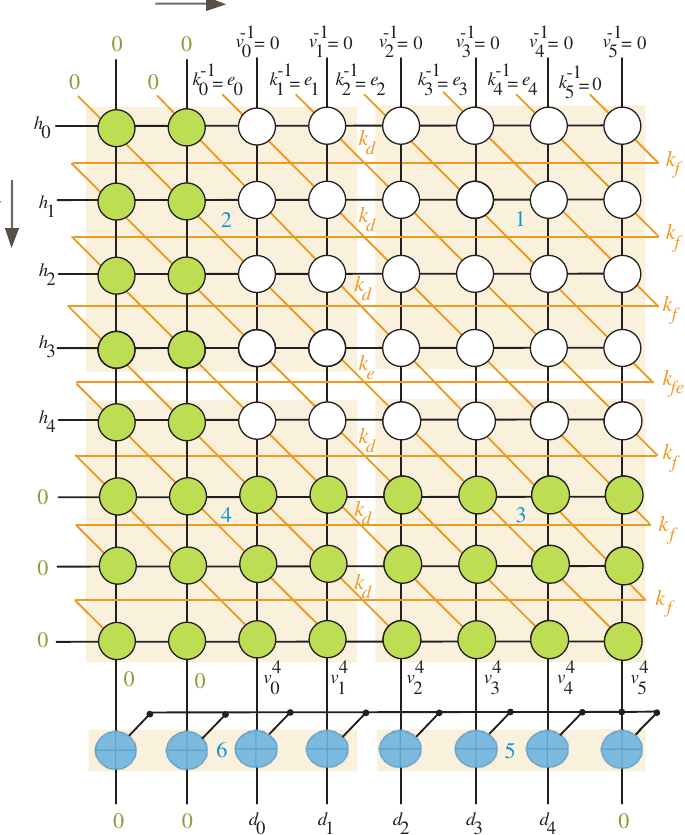
Figure 3. Scheduling time for n = 5 and l = 4.